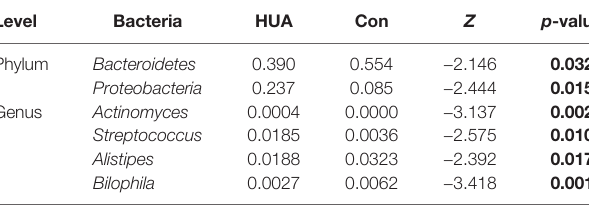
TABLE 3 | The mean relative abundance of gut microbiota in HUA and Con subjects with signi fi cant differences.